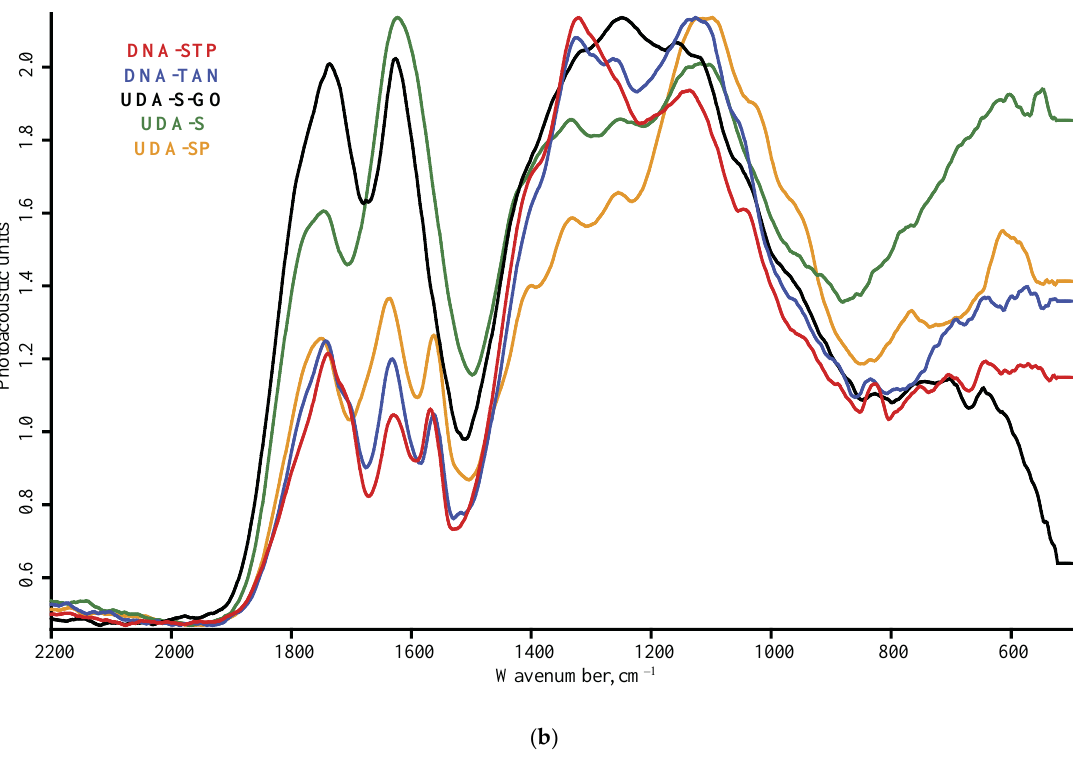
Figure 5. Photoacoustic mode, 1.6 kHz; nanodiamond brands: red, DNA-STP; blue, DNA-TAN; black, UDA-S-GO; green, UDA-S; orange, UDA-SP; ( a ) 4000–2200 cm − 1 , ( b ) 2200–400 cm − 1 range. Spectra were smoothed (25 points) and normalized to maximize each spectrum.